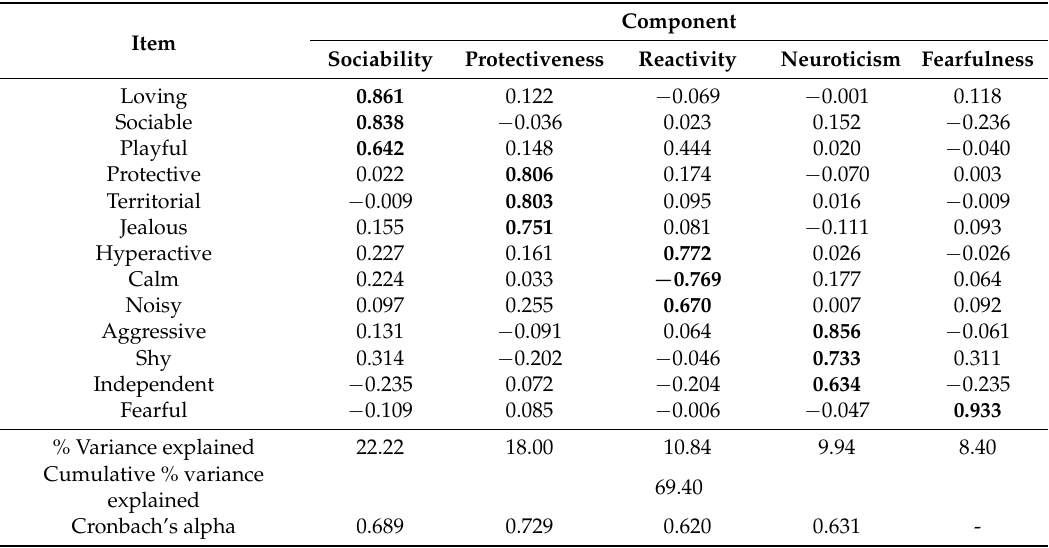
Table 1. Factor loadings for the behavioural subscales of dogs and cats living in the same household derived from a principal component analysis of survey items.